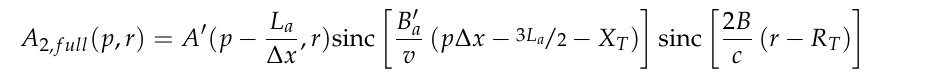
Ambiguity free area